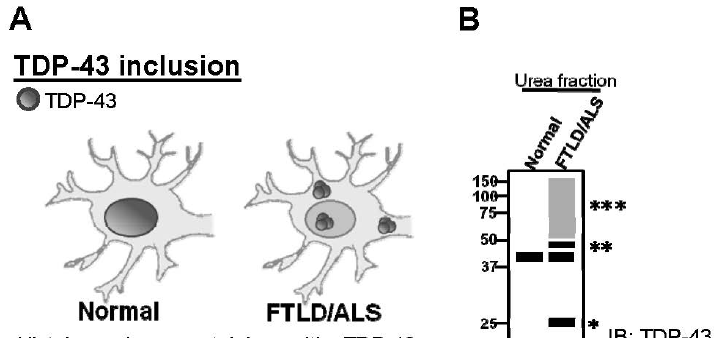
Figure 2. Experiments to examine TDP-43 proteinopathy in diseases animal models. ( A ) In histological staining with TDP-43 antibody, physiological TDP-43 is predominantly expressed in the nucleus of neurons, whereas in FTLD/ALS patients, TDP-43 would form inclusion bodies in the cytoplasm (NCI) or nuclear (NII); ( B ) Truncated TDP-43, phosphorylated TDP-43 and ubiquitinated TDP-43 is expressed in TDP-43 inclusions; ( C ) Through co-immunostaining with TDP-43 and ubiquitin antibody, signals of ubiquitin and TDP-43 would be detected in different subcellular localizations. However in FTLD/ALS, TDP-43 would co-localize with ubiquitin in the nucleus to form NII or in the cytoplasm to form NCI; ( D ) TDP-43 is tightly associated with ubiquitin in the CNS of FTLD/ALS by co-immunoprecipitation. * truncated TDP-43 (25 kDa); ** phosphorylated TDP-43; *** high molecular TDP-43 (ubiquitinated